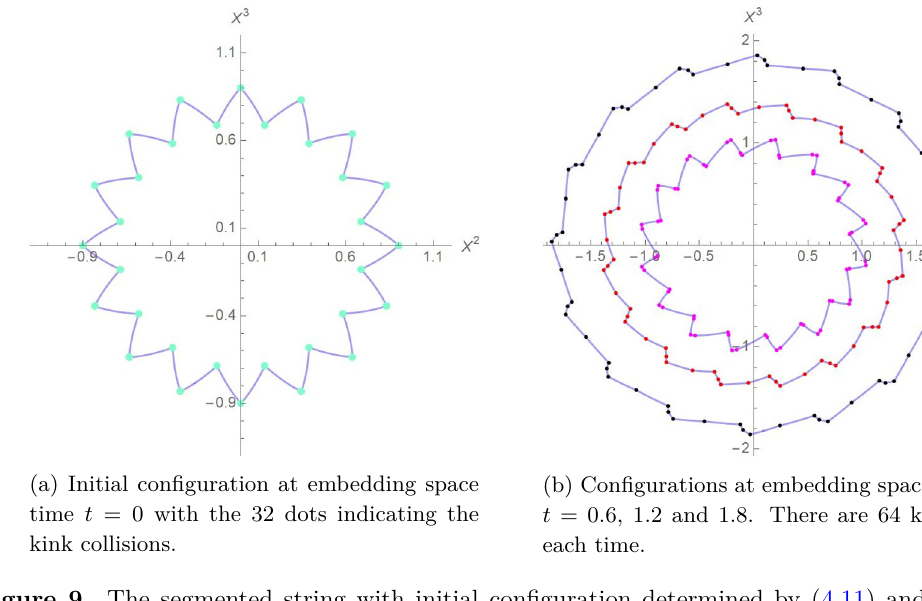
Figure 9 . The segmented string with initial configuration determined by (4.11) and (4.12) has angular momentum larger than its energy and expands towards the horizon. After 3 iterations the string has partially left the static patch. After 10 iterations the different collisions are causally disconnected and the evolution law breaks down. On the right we see the configuration at interme- diate times, when two kinks have come out of each collision and move on to collide with the next